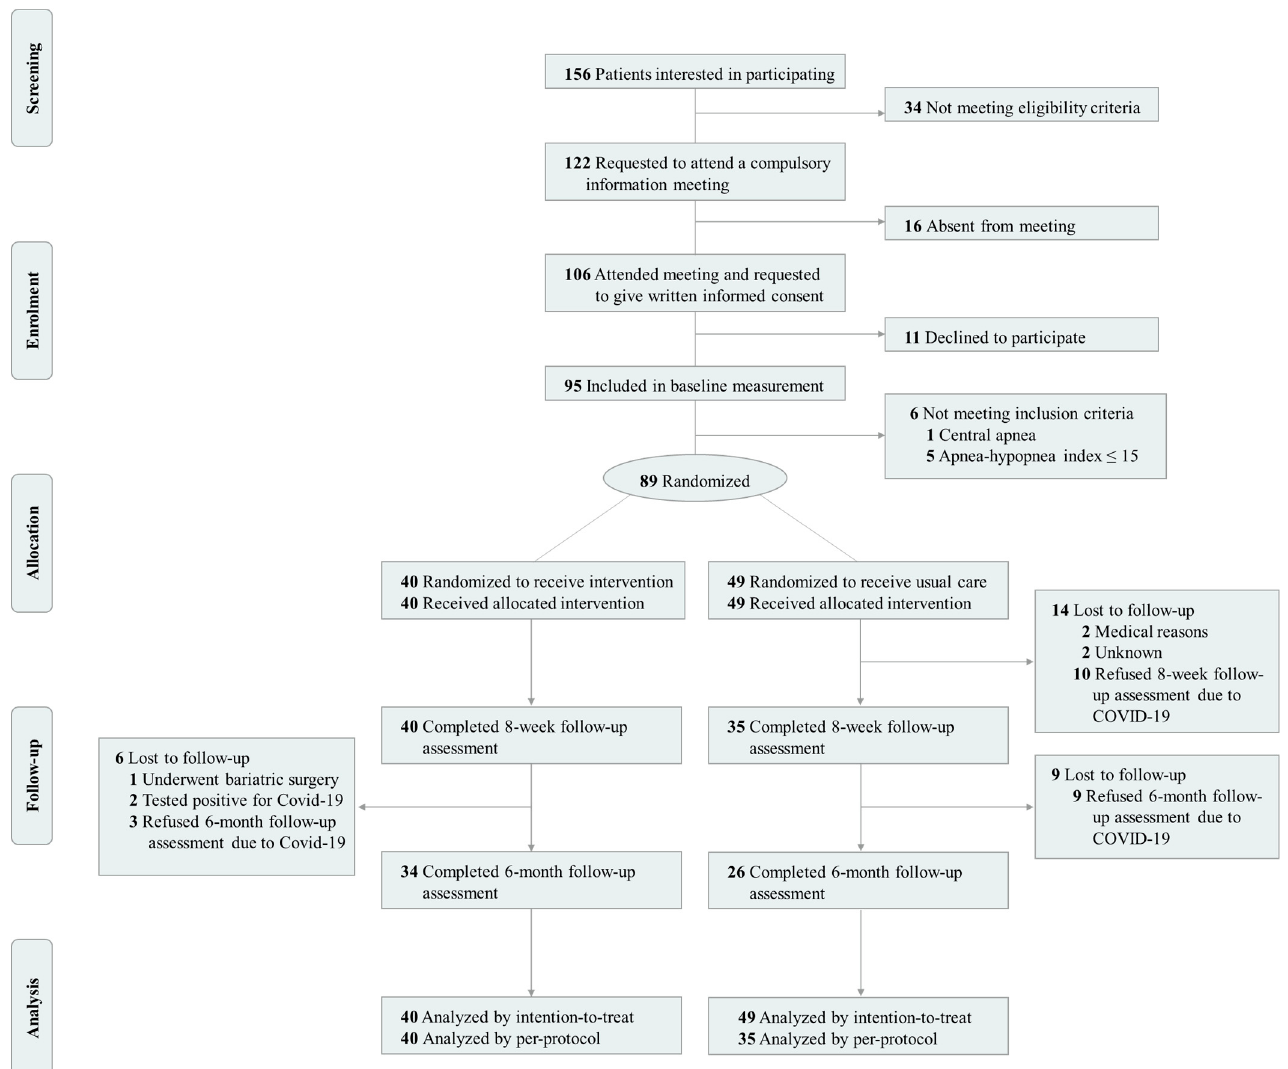
Figure 1. Flow-chart diagram of the INTERAPNEA randomized clinical trial.